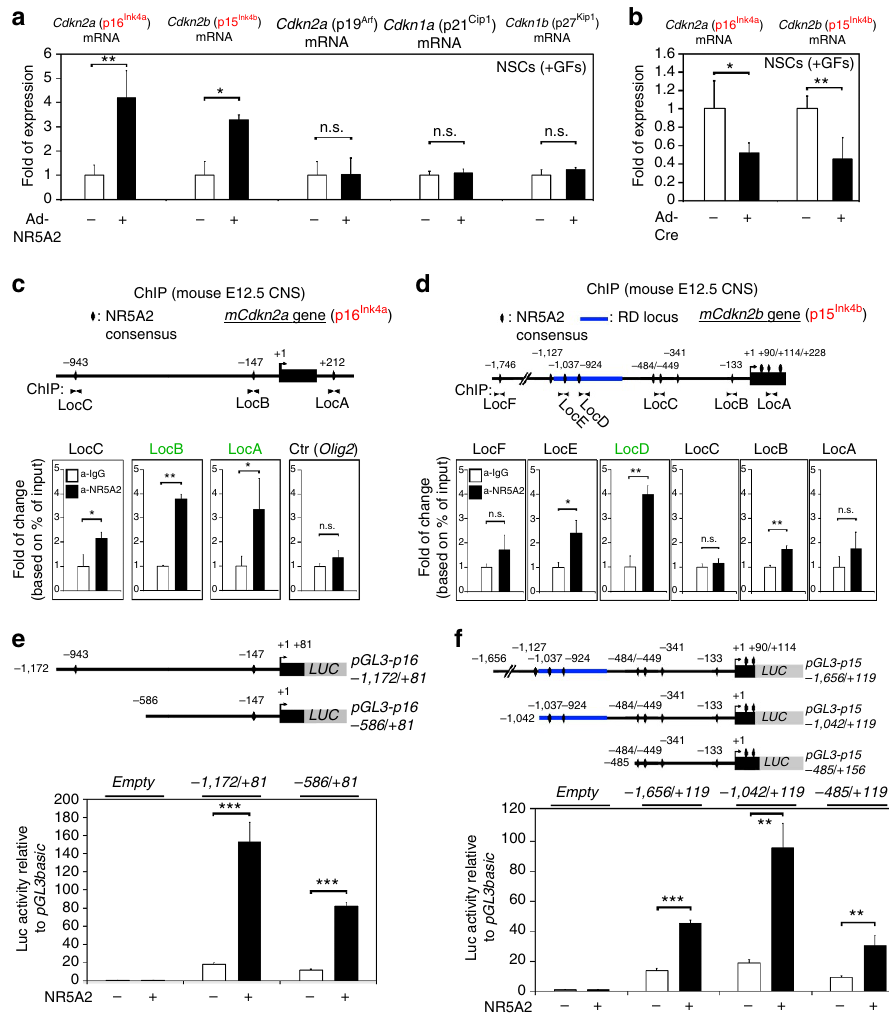
Figure 8 | NR5A2 regulates the Cdkn2a (p16 Ink4a ) and Cdkn2b (p15 Ink4b ) genes of the Ink4/Arf genomic locus. ( a ) RT–qPCR quantification of various Cdki genes in NSCs infected with GFP- or NR5A2-expressing adenoviruses. ( b ) RT–qPCR quantification of p16 Ink4a and p15 Ink4b genes in Nr5a2 fl/fl NSCs derived from spinal cords and transduced with Ad-GFP or Ad-Cre (Supplementary Fig. 14). ( c , d ) Schematics of the organization of mouse Cdkn2a ( c ) and Cdkn2b ( d ) gene loci (upper panels). The lower panels present ChIP analyses for NR5A2 binding in chromatin prepared from E12.5 CNS. ( e , f ) Schematic representation of a number of luciferase-reporter constructs containing various fragments of the mouse p16 Ink4a promoter ( e ) or p15 Ink4b promoter ( f ). The lower panels present transcriptional luciferase-reporter assays in N2A cells, as indicated. The results are shown as mean ± s.d. NS, not significant. P 4 0.05, *P o 0.05, * *P o 0.01, ** *P o 0.001 (Student’s t